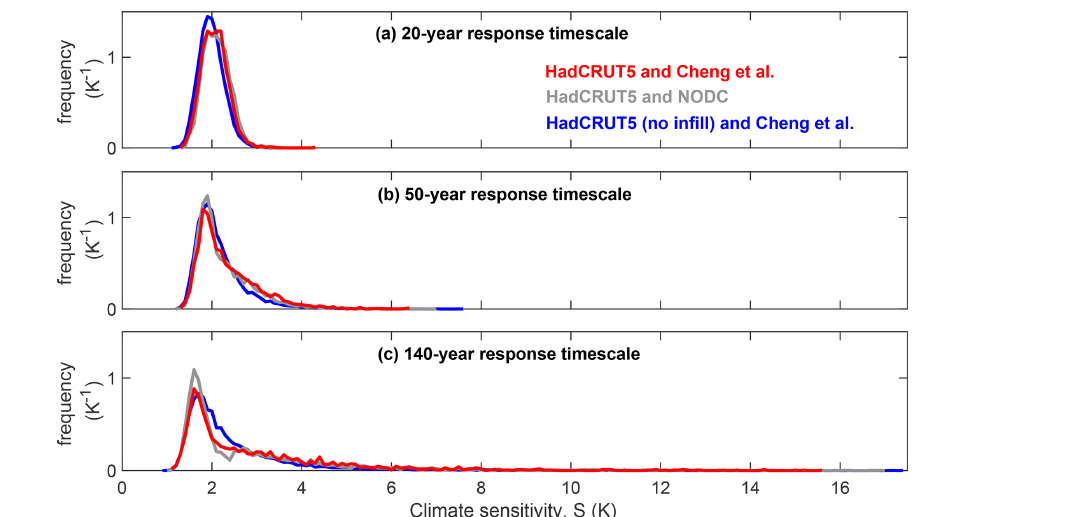
Figure 5. Probabilistic estimates of climate sensitivity (S) for different combinations of observational constraints over (a) a 20-year response timescale, (b) a 50-year response timescale, and (c) a 140-year response